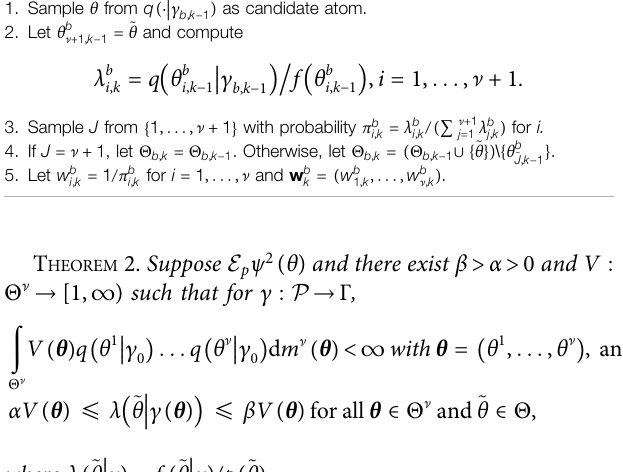
(cid:5)(cid:5)(cid:5)(cid:5) ) as candidate atom. c b , k − 1